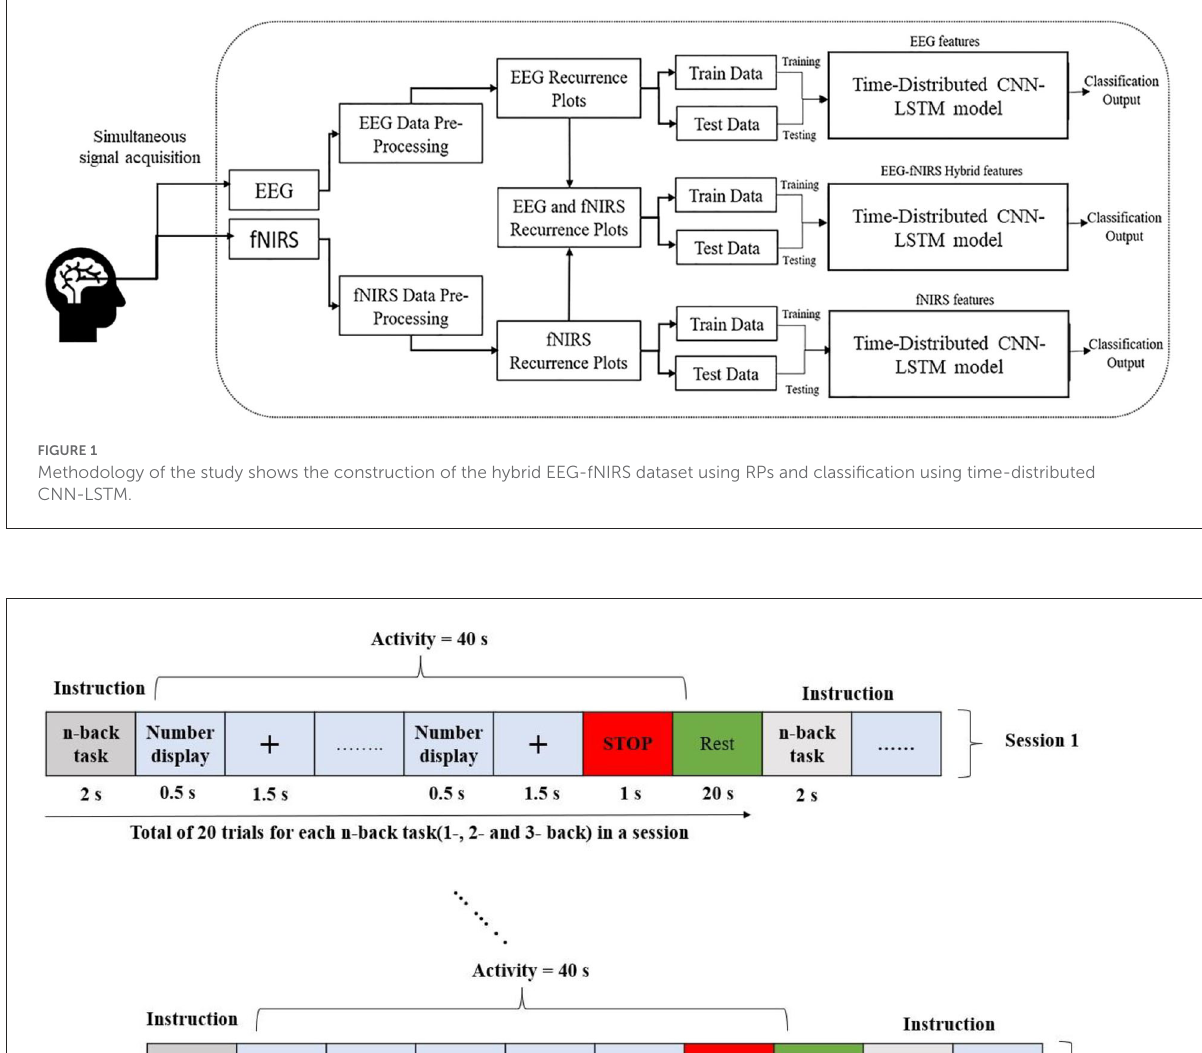
chosen to be 0.2Hz. The data were acquired using MATLAB R2013b software. Further processing was performed using Python on Spyder in the Anaconda development environment. After filtration, the dataset was labeled using the activity time markers from the acquired continuous EEG and fNIRS signals. Four classes, namely, 0-, 2-, and 3-back classes, and one of the remaining states, were labeled concerning the experimental protocol. After that, the labeled data were used for RP